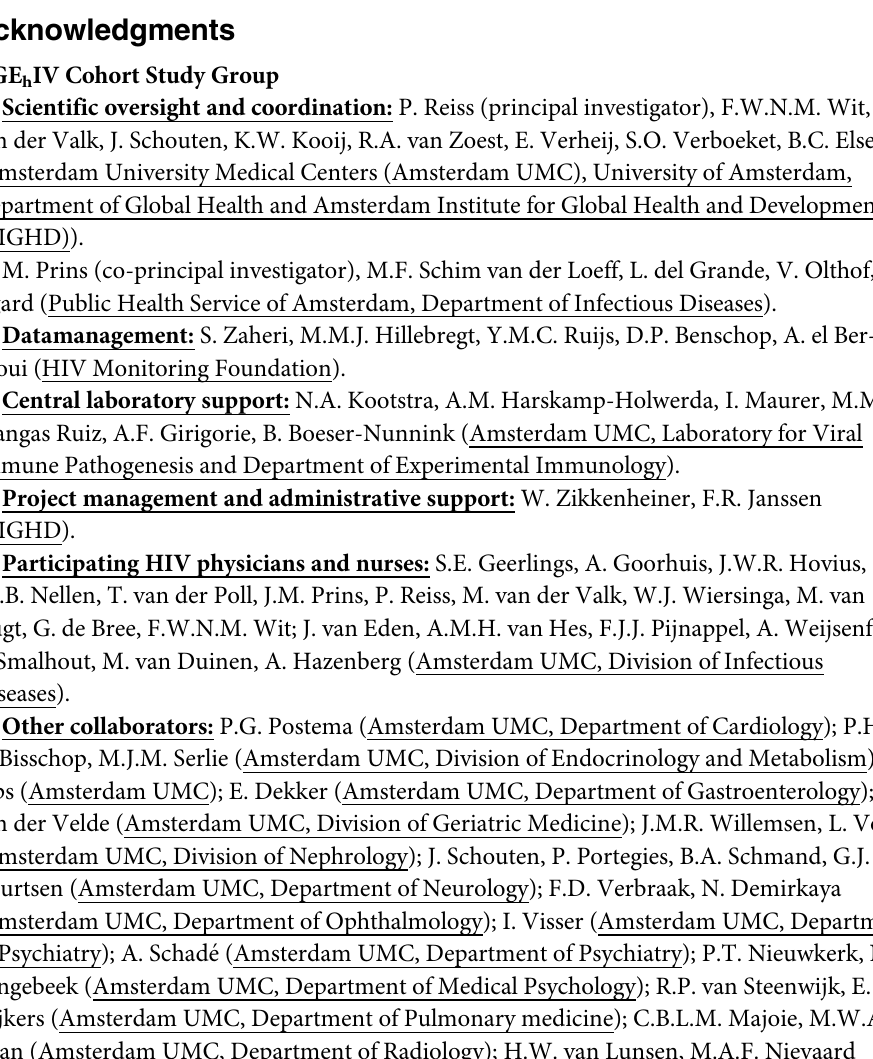
S2 Fig. Time-dependent propensity score matching of control participants to index-partic- ipants and determining their hypothetical moment of switch. 1 HIV-positive non-switching or HIV-negative control. Propensity scores were calculated using a Cox proportional hazard model, including time-updated age and body mass index, and time-fixed gender and ethnicity. Abbreviations: INSTI, integrase strand transfer inhibitor. S1 Table. Nucleoside reverse transcriptase inhibitor use before and after switch to INSTI. S2 Table. Primary reasons for switching to